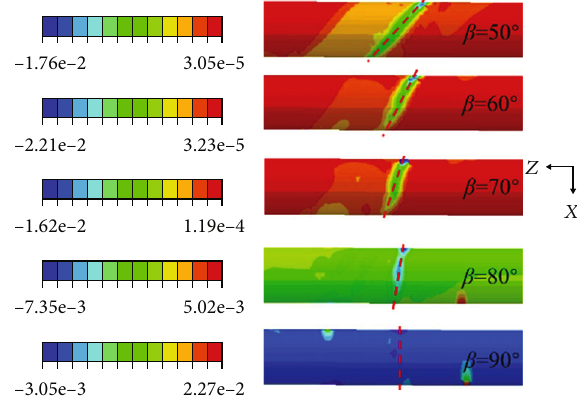
Figure 11: Axial strain of secondary linings under di ff erent tunnel- fault intersection